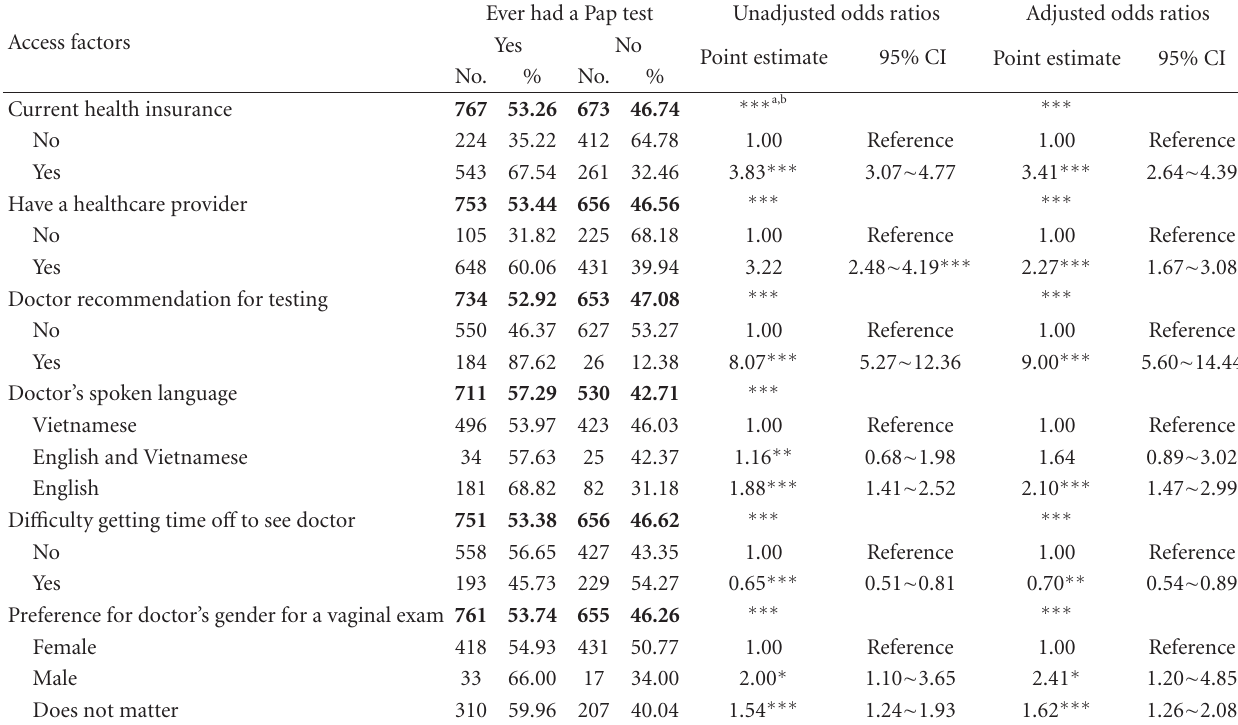
Table 2: Associations between Papanicolaou (PAP) testing and access